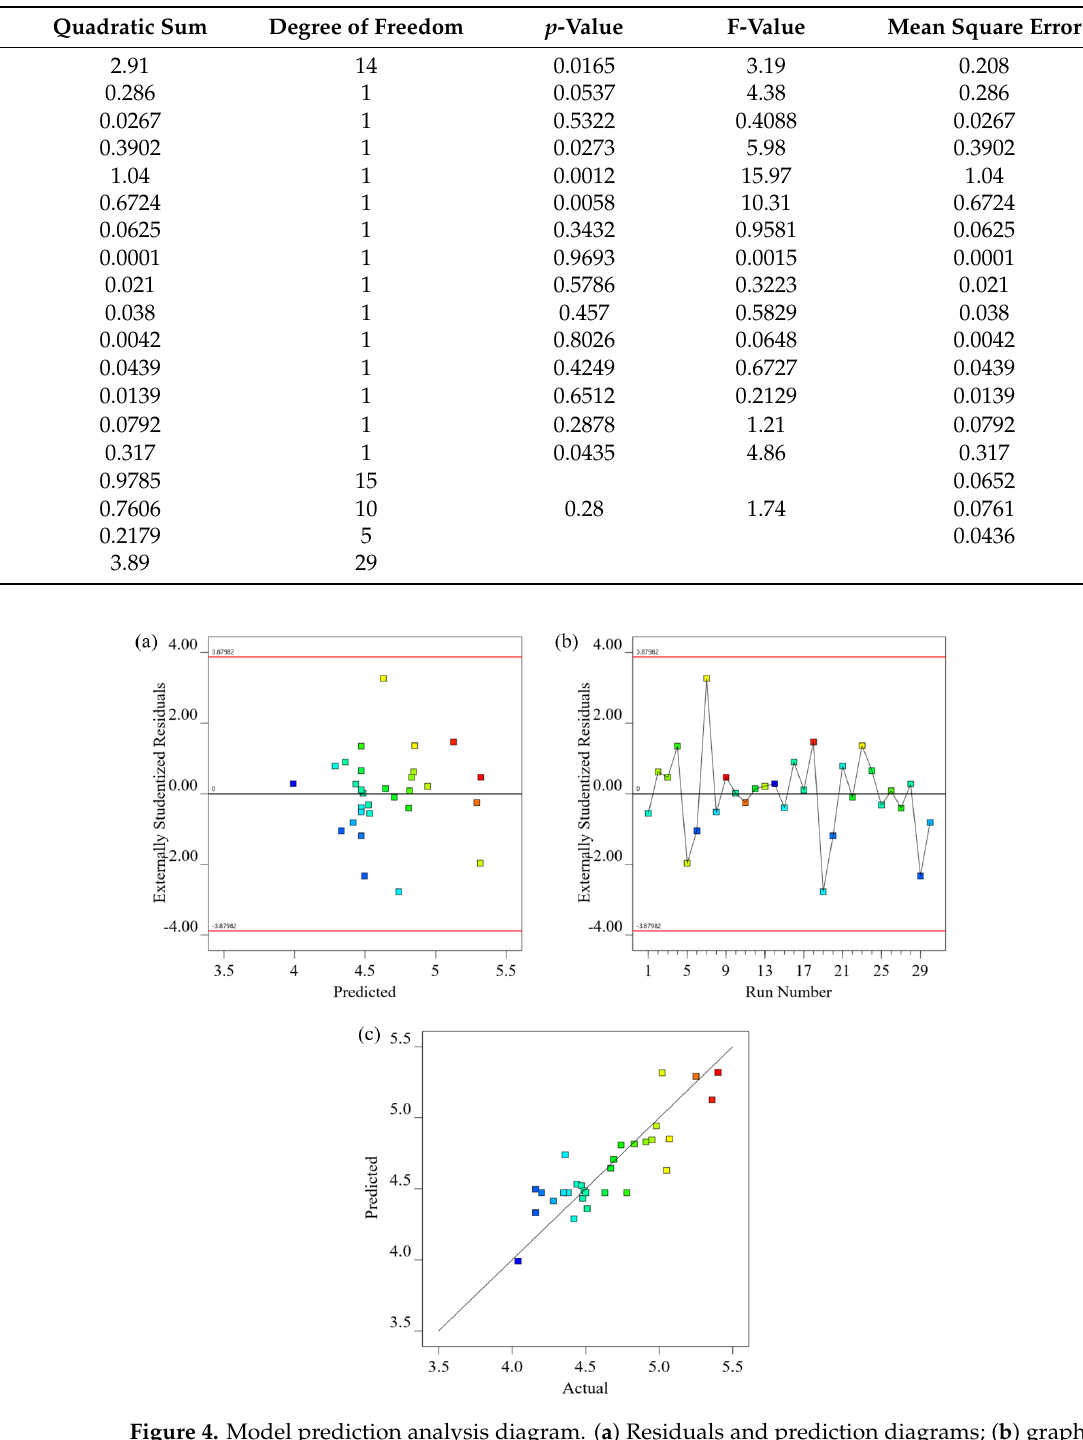
Figure 4b, the horizontal line in the middle is the residual zero line, and the distribution of experimental points on either side of it is random, and there are no data points beyond the upper and lower red lines, so the residual error of the whole model is small. As shown in Figure 4c, the diagonal line is the fitting line, and data points obtained from the experiment are distributed in a relatively close distance on both sides of the fitting line. Table 5. Variance analysis table.